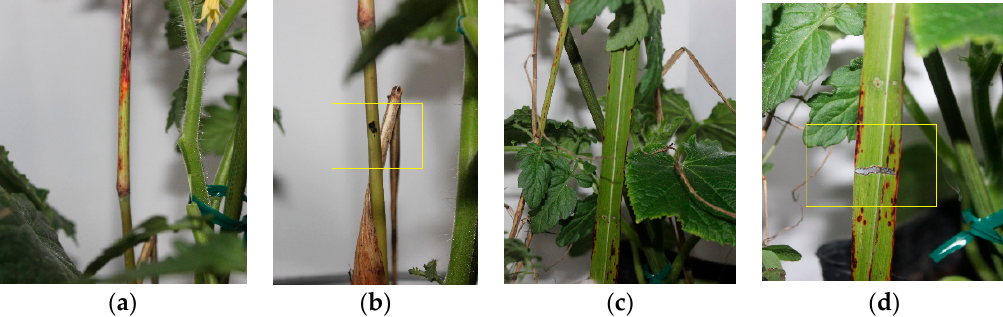
Figure 18. Elytrigia repens plant before and after irradiation with a 1 W laser for 0.5 s. ( a ) The straw before the irradiation; ( b ) the straw after the irradiation; ( c ) the leaf of E. repens before the irradiation and ( d ) after the irradiation.